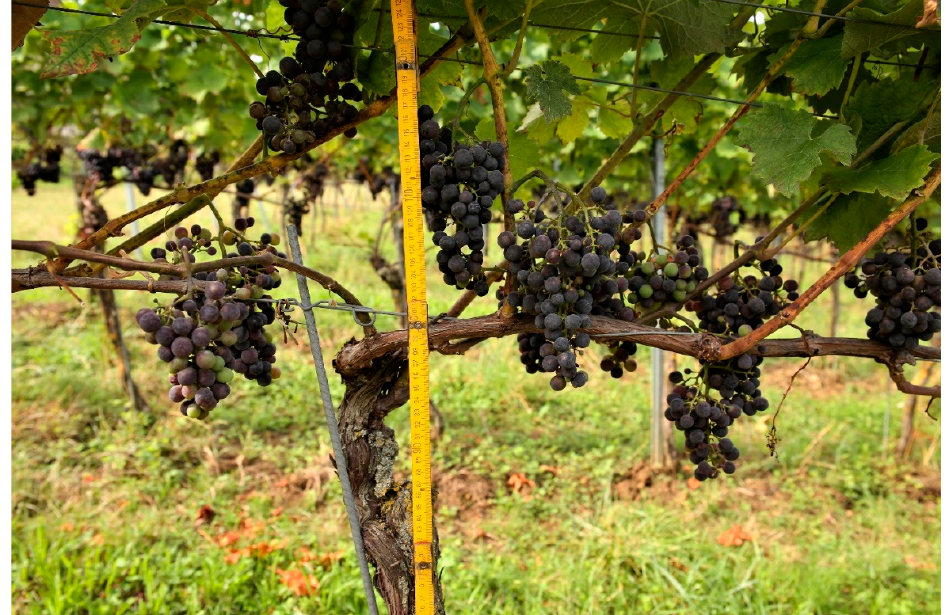
Figure 7. Results after several weeks of grazing and leaf plucking with a small Danish-type Shropshire flock. The result was considered favorable by the winemakers. Optimization could be expected if the lowest wires were raised a little more. Alternatively, the animals would have to be removed from the pasture earlier. As an approximation, the following guideline is valid: the longer sheep are in the vineyard, the higher they defoliate. Breeds that are capable of bipedalism start to use it over time.